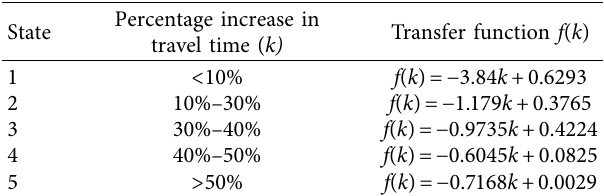
Figure 6: The evaluation process of implementing HOV lane priority dynamic control. Table 3: The state functions of the transfer from private car to